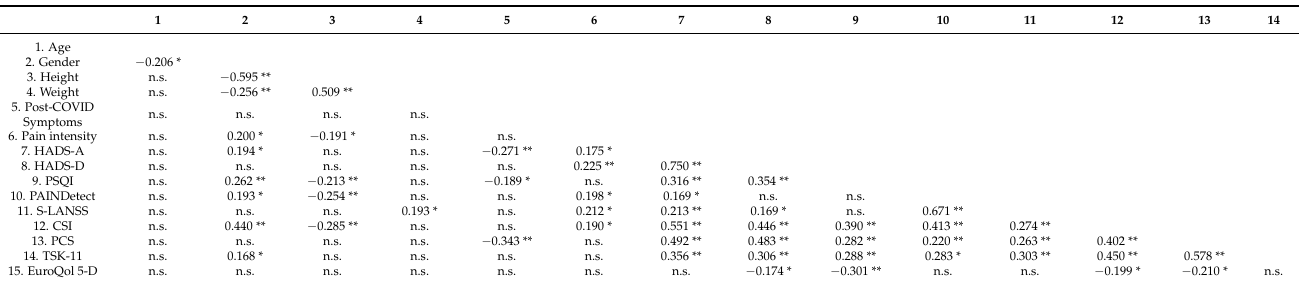
Table 2. Pearson-product moment correlation matrix between sociodemographic, psychological, neuro-physiological and clinical